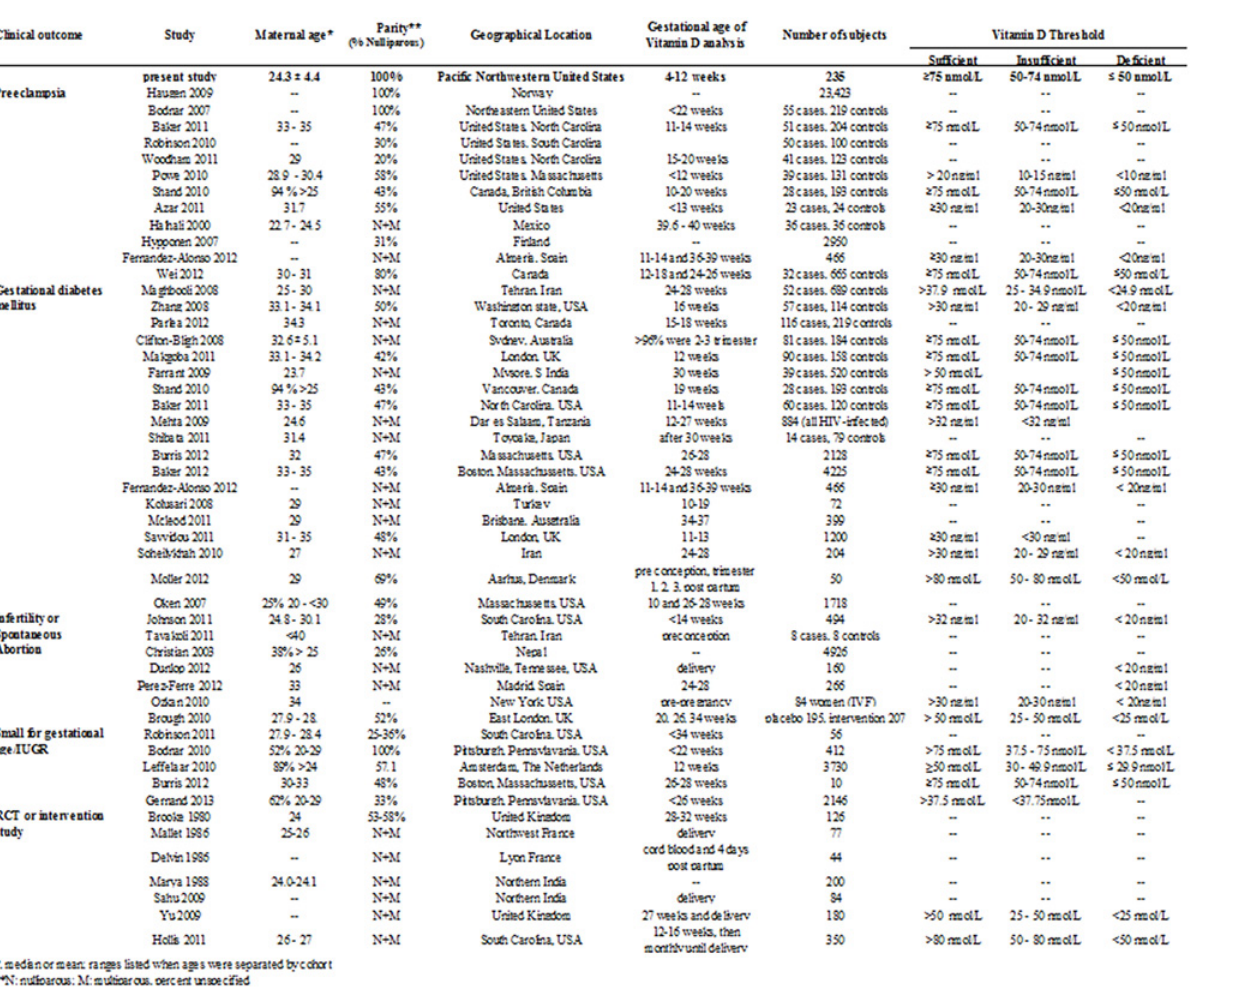
Fig 1. Comparison of study parameters in recent vitamin D observational and intervention